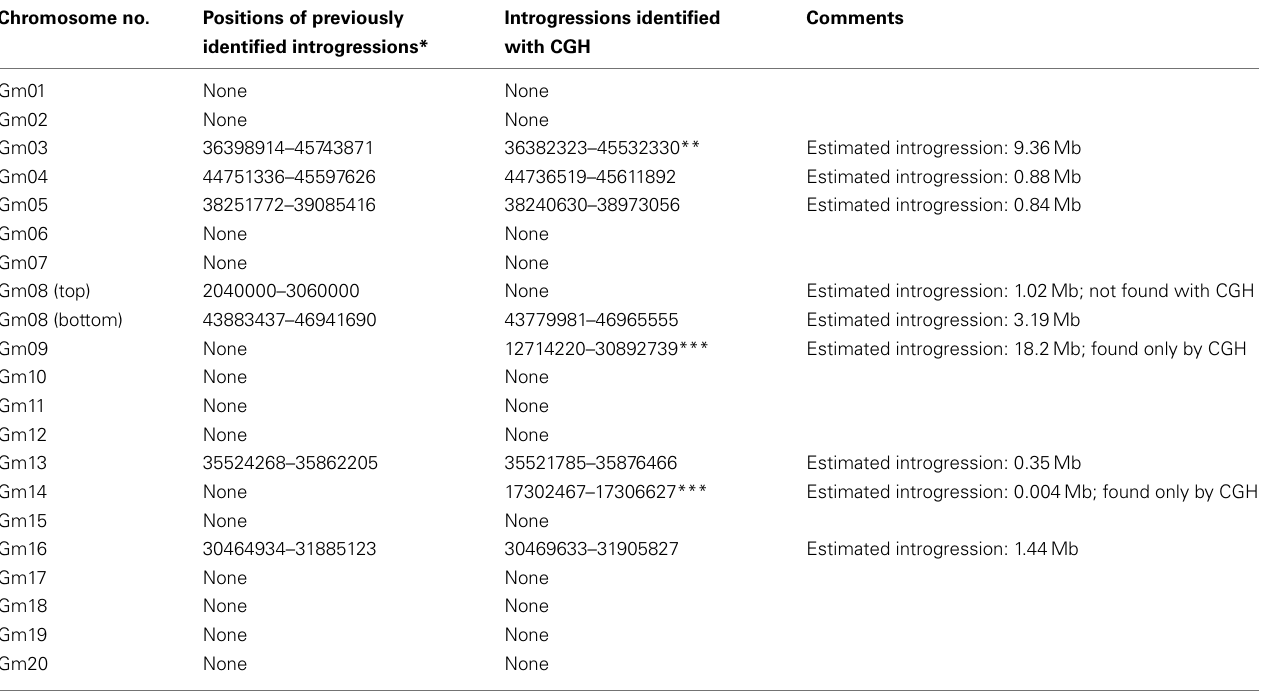
Table 2 | Comparison of introgression sites and CNV boundaries among IsoClark/Clark lines using CGH and other approaches. Chromosome